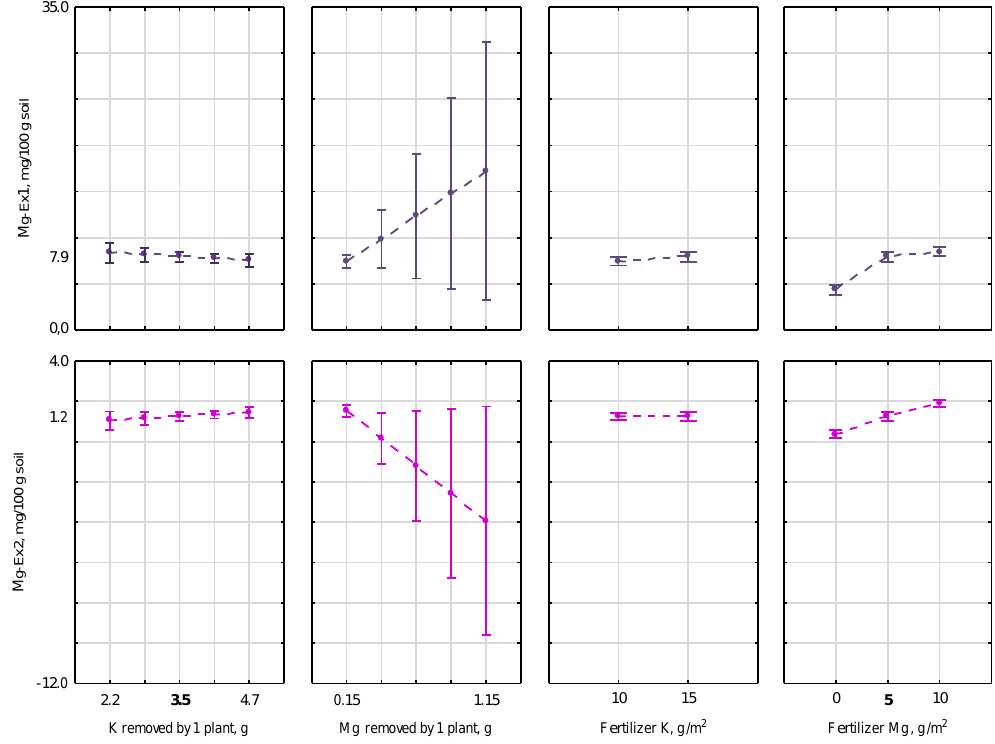
Figure 4. Profiles for predicted values of soil exchangeable Mg according to the GLM model (R 2 = 0.91 for Mg-Ex1 and R 2 = 0.85 for Mg-Ex2). Abbreviations: Mg-Ex1 and Mg-Ex2—soil exchangeable Mg extracted by 1 M CH 3 COONH 4 and 0.0025 M CaCl 2 , respectively. Whiskers denote confidence